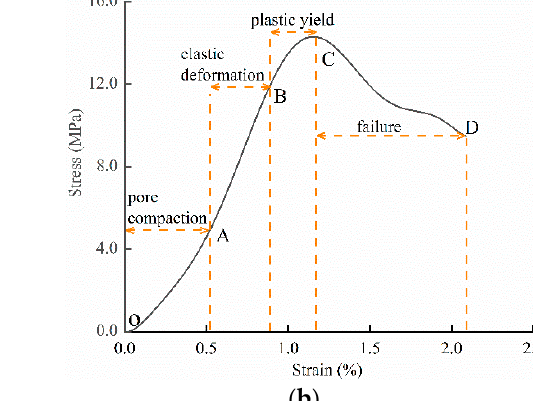
Figure 6. ( a ) Stress–strain curve and ( b ) stage segmentation of backfills with different sizes.